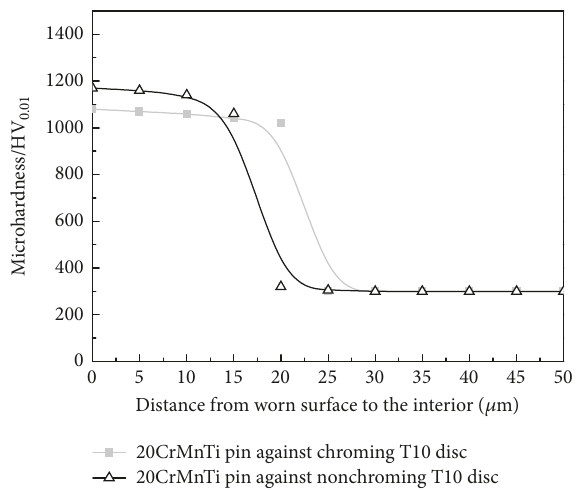
Figure 7: Microhardness profiles of 20CrMnTi pins against (a) chroming and (b) nonchroming T10 discs as a function of the depth beneath worn